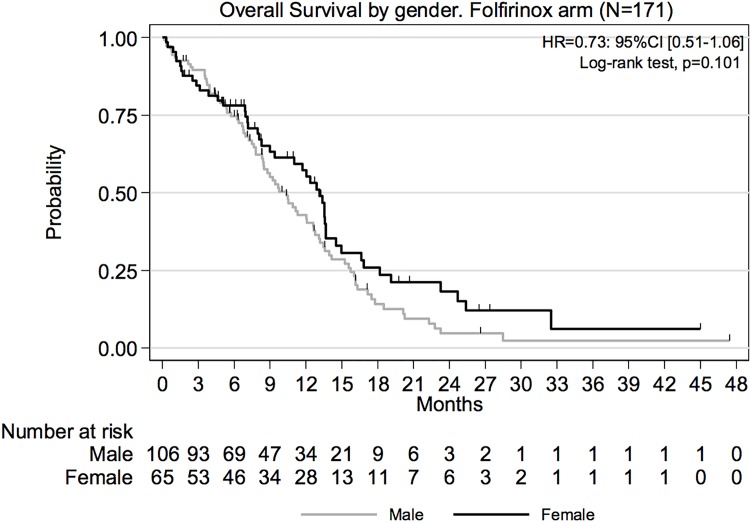
Overall survival by gender, Folfirinox arm.